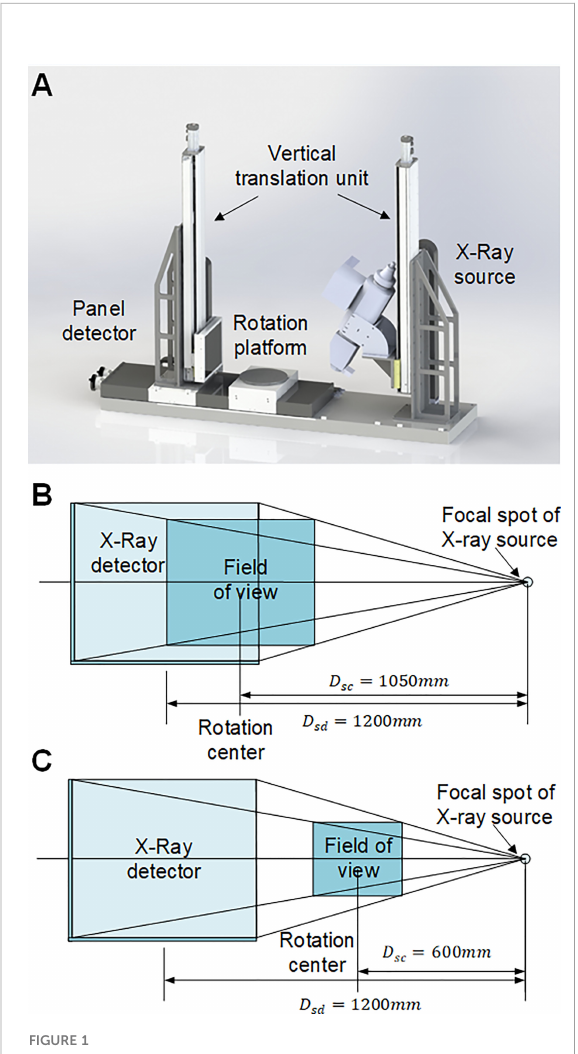
FIGURE 1 Principal components and con fi guration of Micro-CT system. (A) Hardware design of the Micro-CT system. (B) The fi eld of view for coconut fruit imaging. The active area of the panel detector is 248mm ⨯ 298mm with a resolution of 2512 ⨯ 3008 pixels. The distance between the X-ray source and the detector (DSD) is 1200 mm, the distance between the X-ray source and the rotation center (Dsc) is 1050 mm; thus, the fi eld of view is 217mm ⨯ 260mm, and the spatial resolution can be calculated as 86 m m ⨯ 86 m m. (C) The fi eld of view for coconut seed